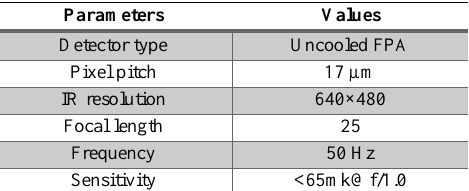
Figure 3. Automatic detection of targets centres